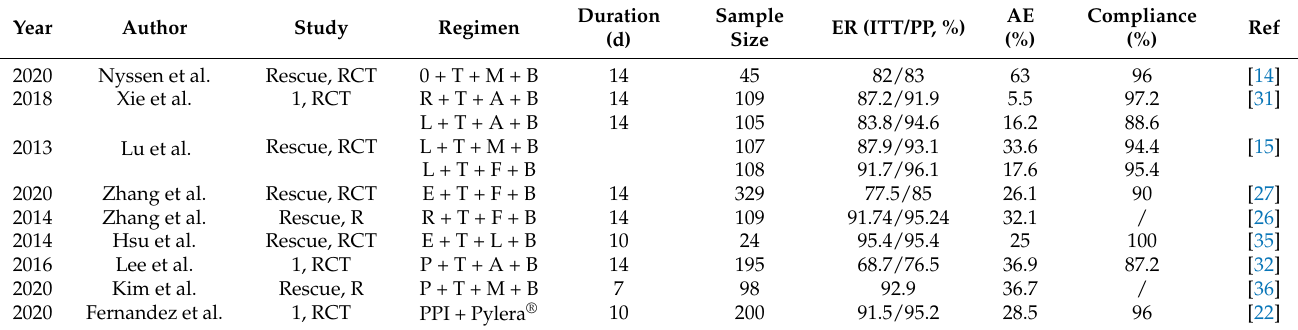
Table 1. Studies of tetracycline-containing bismuth quadruple regimens in HP-infected